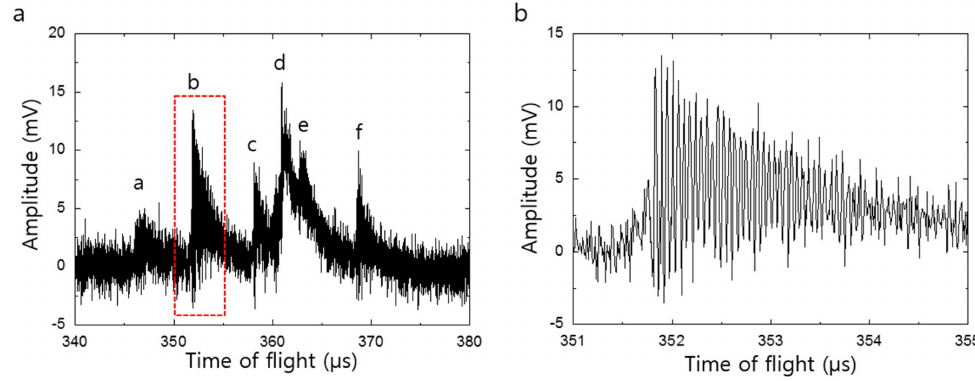
Figure 2. MALDI TOF mass spectrum for IgG. ( a ) Mass spectrum obtained using silicon nanomembrane detector after eliminating system noises by the band block filtering with the lower and upper cutoff frequency of 1 MHz and 8 MHz, respectively. It shows multiple peaks at the time-of-flight of the singly charged IgG; ( b ) The magnified view of the peak enclosed by dashed lines. This clearly shows modulation of phonon-assisted field emission which stems from the mechanical vibration of the nanomembrane with resonance frequency of 17.5